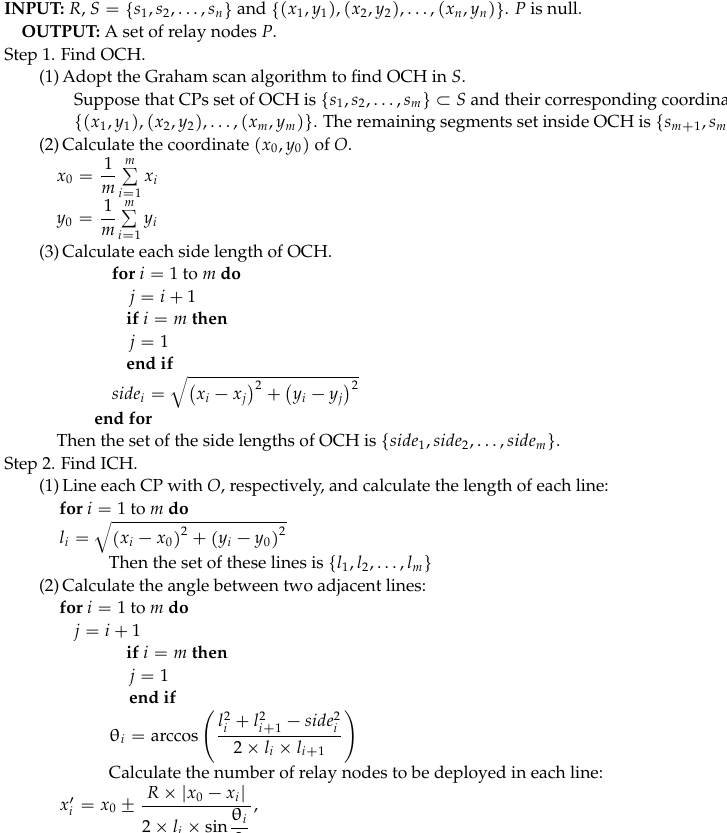
Algorithms 1 F2CRA INPUT: R , S “ t s 1 , s 2 ,..., s n u and tp x 1 , y 1 q , p x 2 , y 2 q ,..., p x n , y n qu . P is null. OUTPUT: A set of relay nodes P . Step 1. Find OCH. (1)Adopt the Graham scan algorithm to find OCH in S